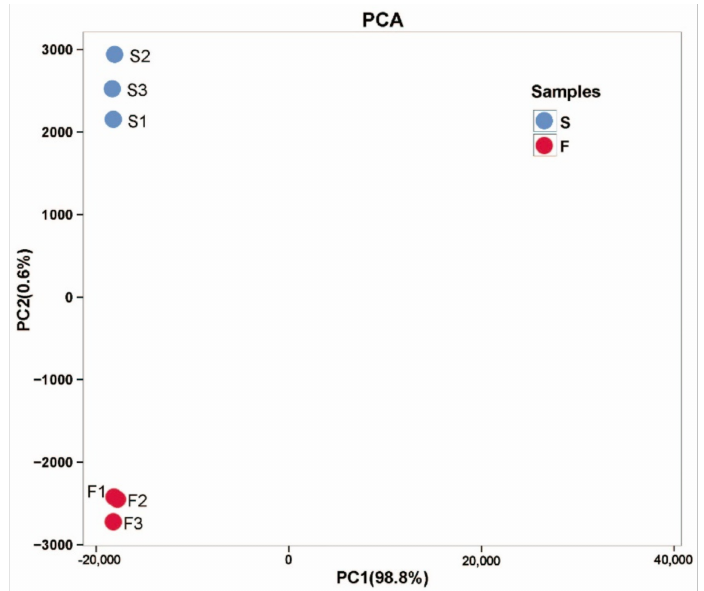
Figure 2. PCA analysis of the principal components in F and S cell lines of Korean pine. Note: The X-axis represents the first principal component, and the Y-axis represents the second principal